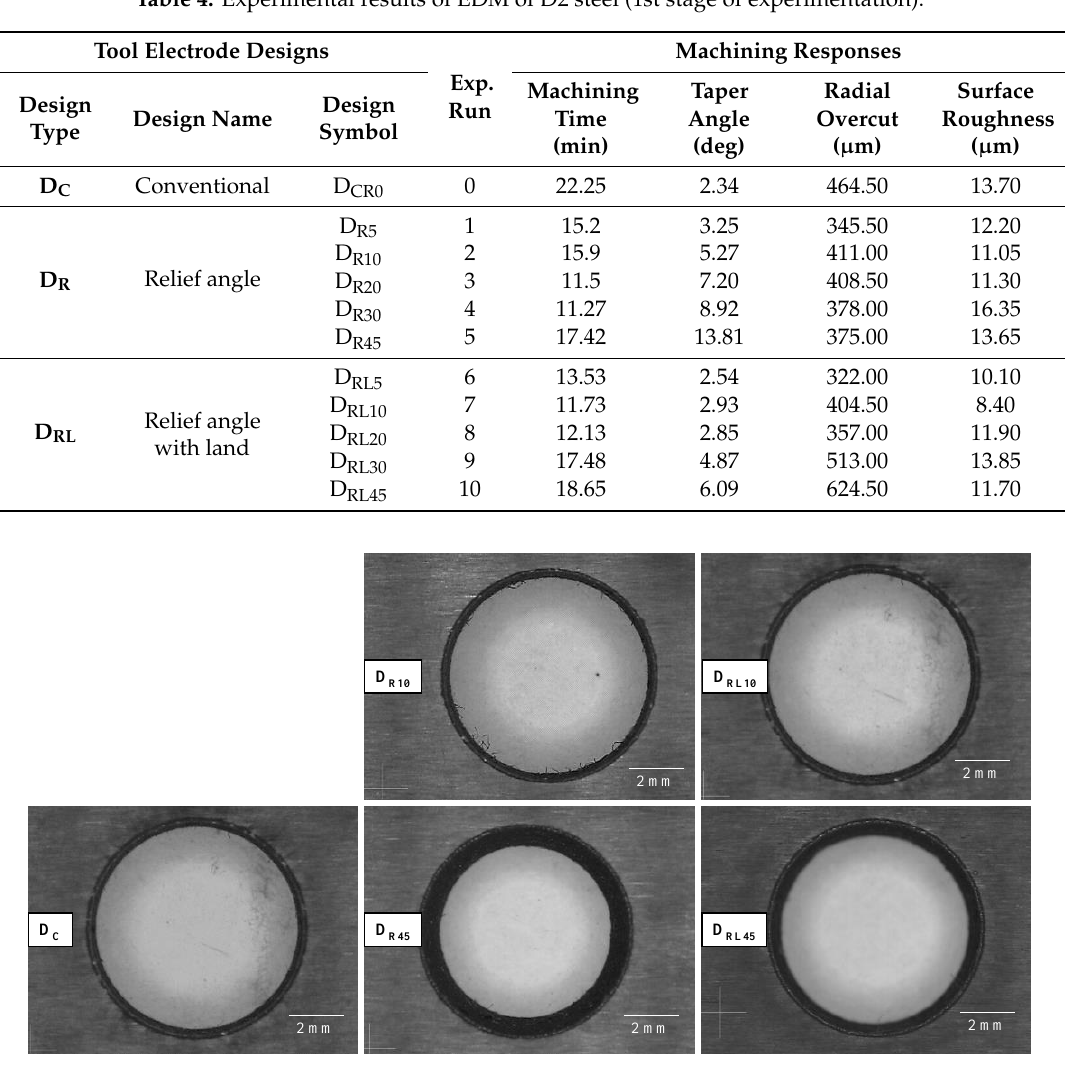
Figure 3. Machined holes produced through different electrode designs (D C , D R , and D RL ).